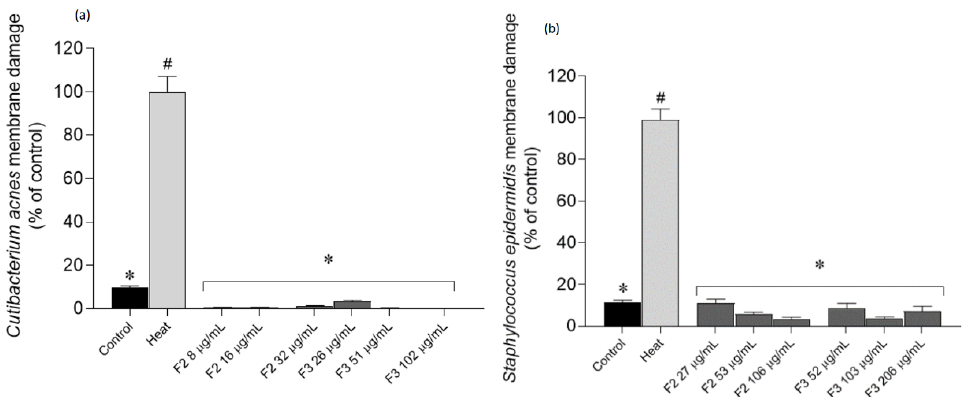
Figure 5. Cutibacterium acnes ( a ) and Staphylococcus epidermidis ( b ) membrane integrity when exposed to Gelidium corneum F2 and F3 fractions at ½ IC 50 ; IC 50 and 2 × IC 50 , labelled with Sytox Green probe. Bacterial cells exposed to a heat treatment were used as a positive control. DMSO was used as negative control. Each value represents the average of three independent experiments. Bars represent the standard error of the mean (SEM). Symbols represent significant differences when compared to the heat-treated cells (*) and ( # ) to control (ANOVA, Dunnett’s test, p < 0.05). After an incubation with the most active fractions, it was possible to verify that they did not promote membrane damage, since there were no significant differences in relation to the untreated control.